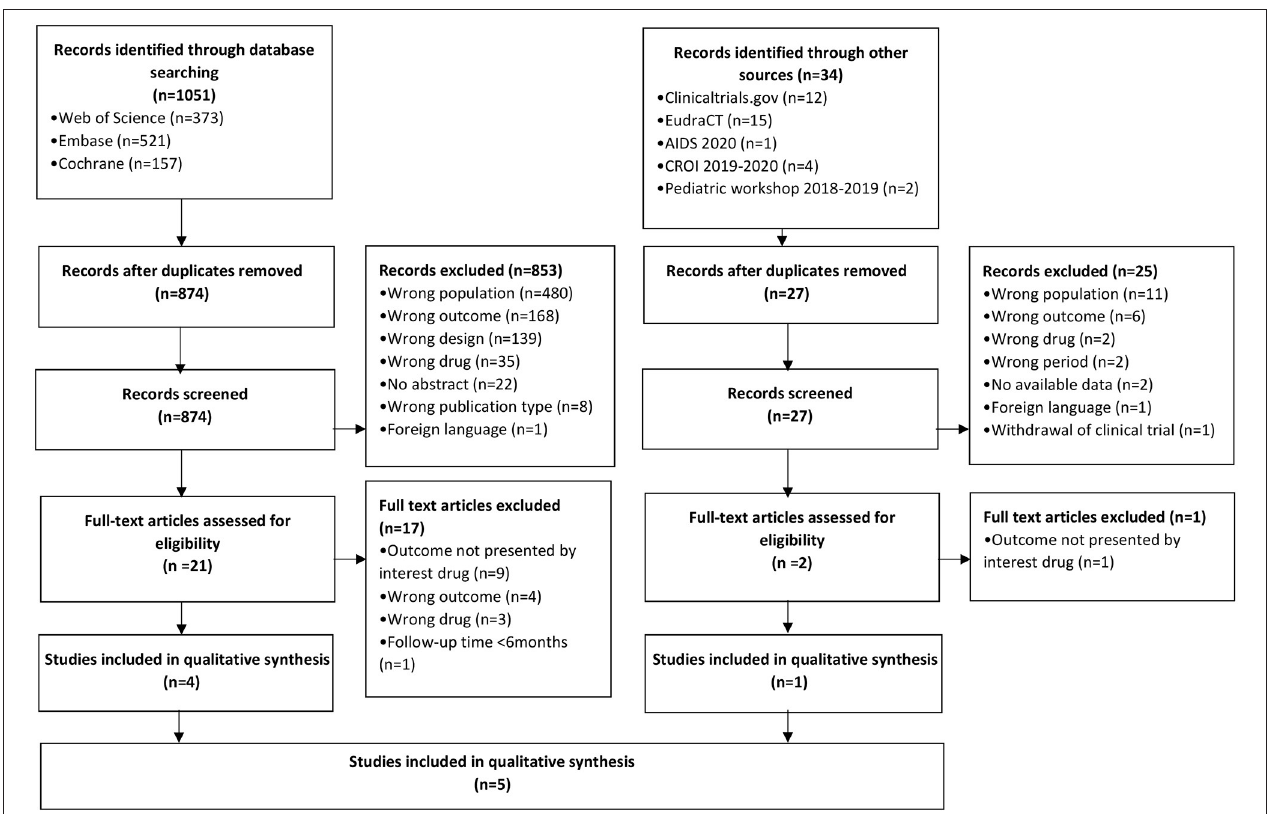
FIGURE 1 | PRISMA flow diagram of study selection on atazanavir toxicity in children and adolescents (2009/01/01- 2020/10/01). CROI, Conference on Retroviruses and Opportunistic Infection.